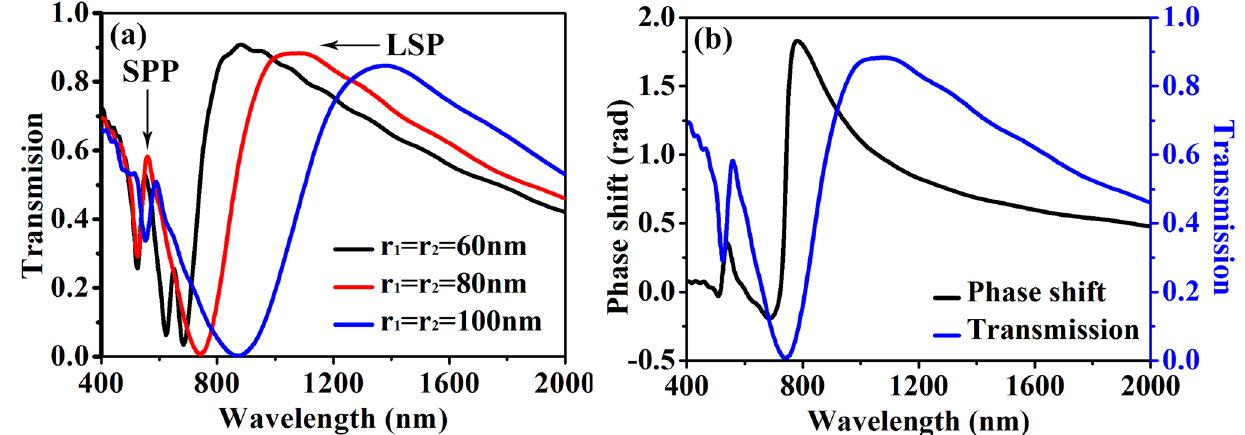
Figure 2. Performance of the hollow ring. ( a ) The transmission at r 1 = r 2 = 60 nm, 80 nm and 100 nm, respectively. ( b ) the transmission and the phase shift at r 1 = r 2 = 80 nm. The other parameters are